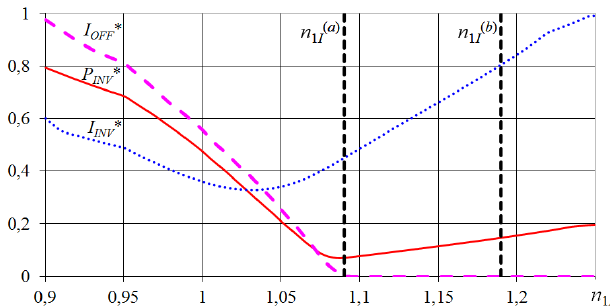
Figure 5. Relative power dependences of the Figure 4. Inverter frequency characteristics in the inverter and the elements of the resonant LC-circuit idle mode: on the parameter m at idle: S INV* – inverter output power; P INV* – power losses in inverter; S C* ,S L* – capacitor and reactor capacities,